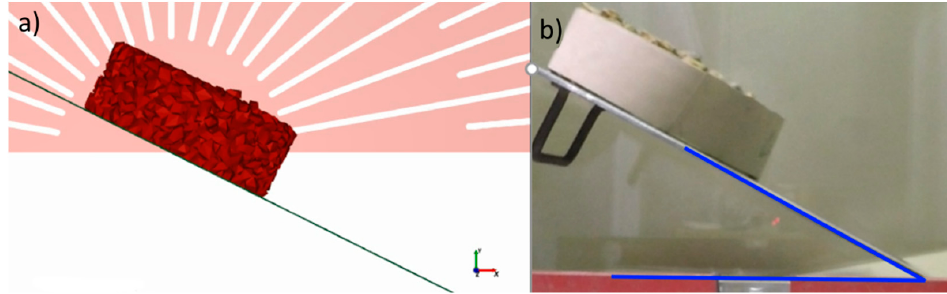
Figure 7. Friction coefficient “ore-steel” experiment conditions. ( a ) Simulated experiment, ( b ) Laboratory experiment.